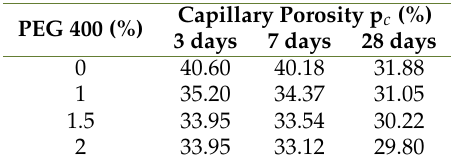
Fig. 6. Capillary Porosity Values at 0.34 Water-Cement Ratio.